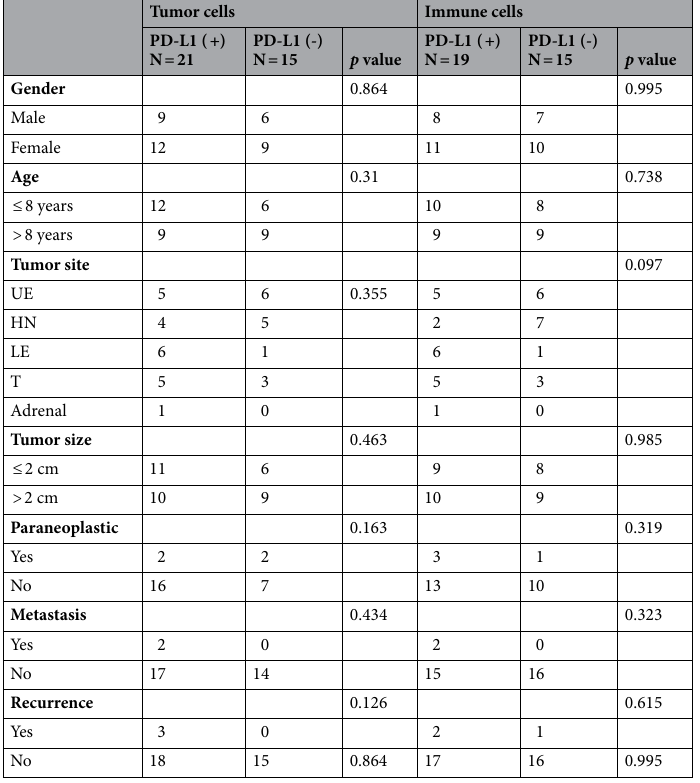
Table 2. The relationship between the status of PD-L1 expression and clinicopathologic parameters of AFH. UE, upper extremity; HN, head and neck; LE, lower extremity; T, trunk, p value < 0.05 was considered